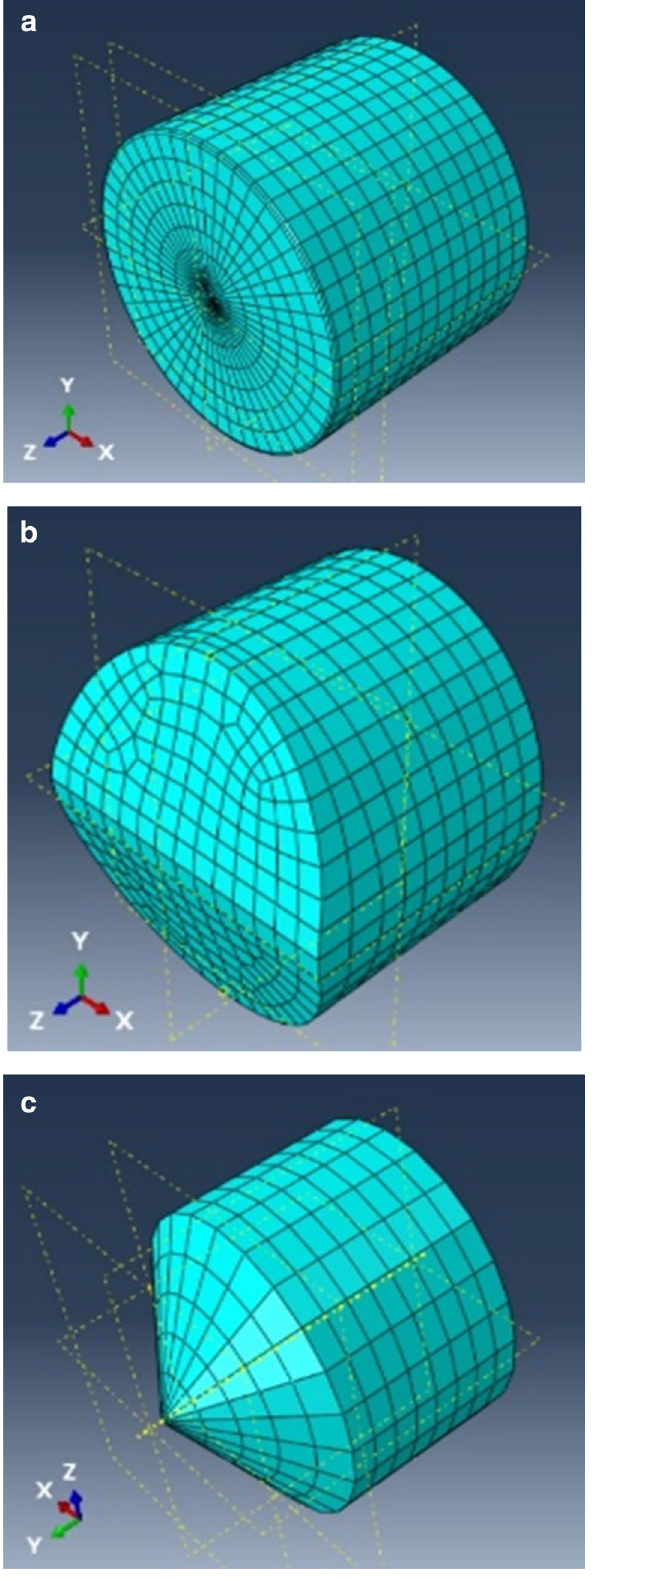
Fig. 7 a Chamfered cutter mesh. b Ax cutter mesh. c Stinger cutter